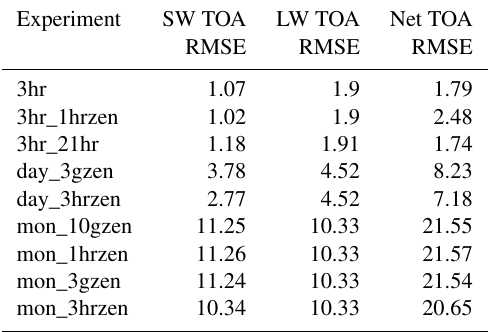
Table 4. Root-mean-square error (RMSE, in Wm − 2 ) of monthly top-of-atmosphere (TOA) radiation compared to CERES-EBAF for 2003. Experiment